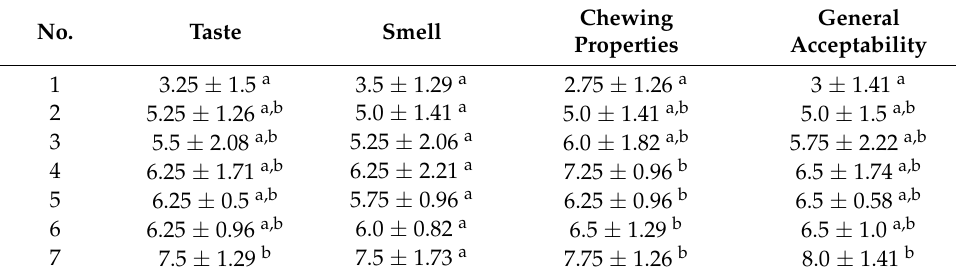
Table 7. Consumer acceptance test results of the muffins. No.